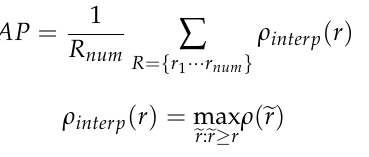
Table 3. Few-shot performance on GTSDB test set for novel classes. For the novel categories, we analyze performance for various numbers of training shots.